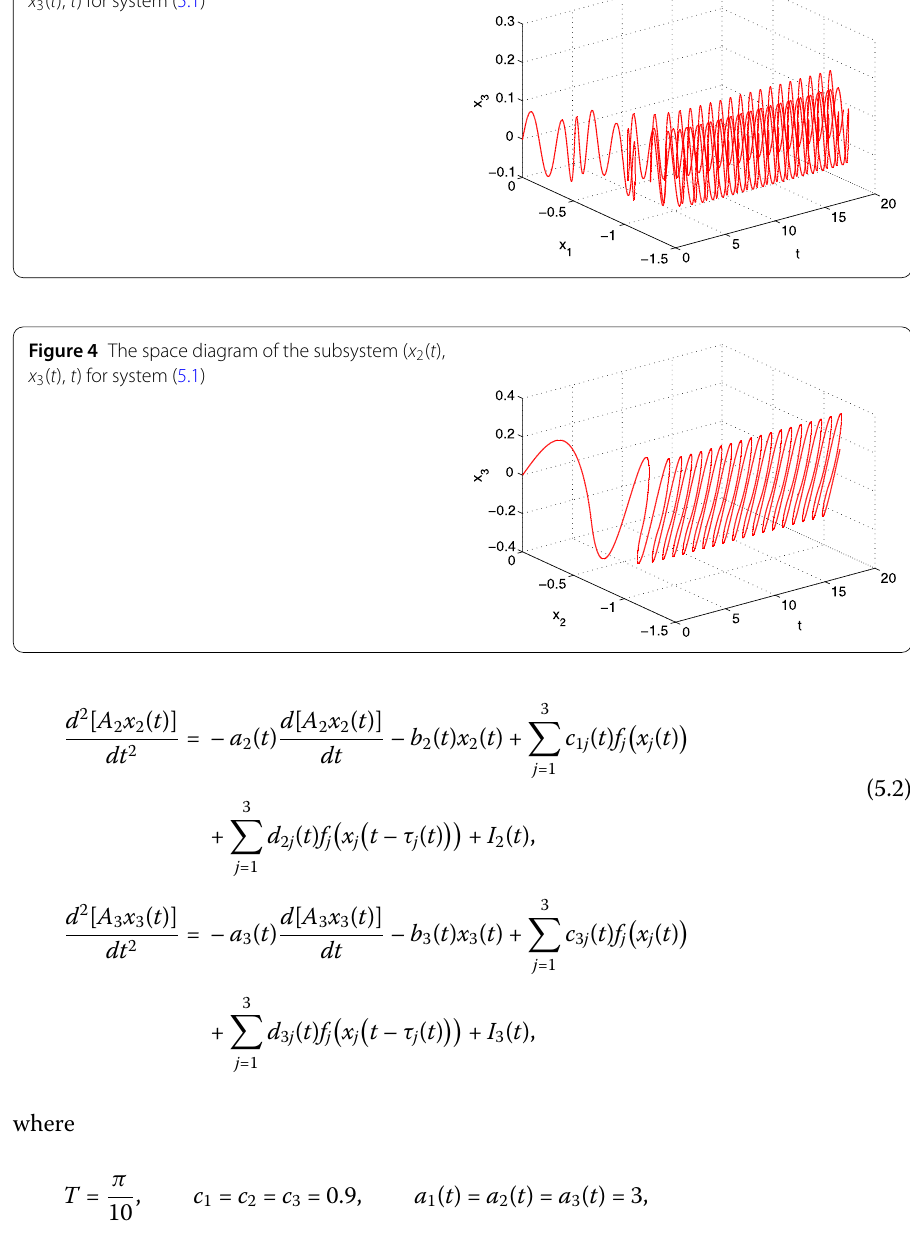
Figure 3 The space diagram of the subsystem ( x 1 ( t ), x 3 ( t ), t ) for system (5.1)